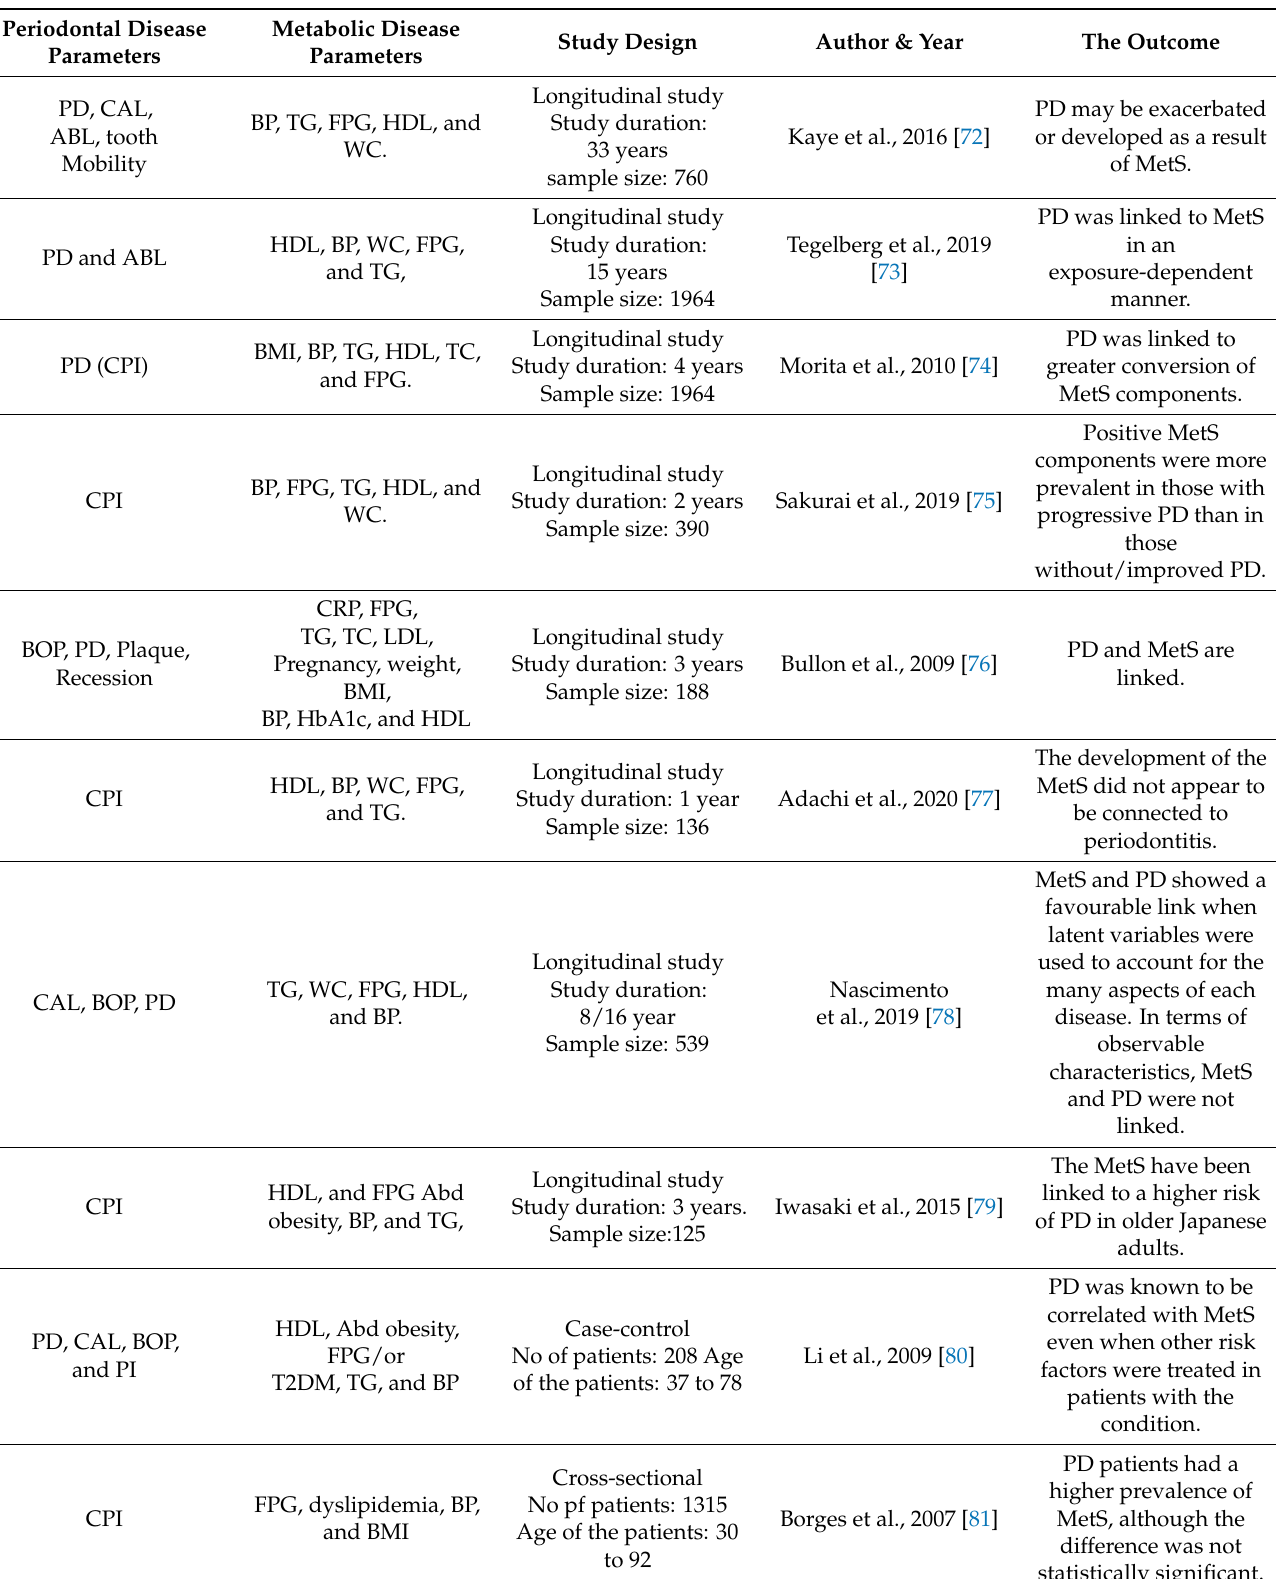
Table 1. Correlation between PD and